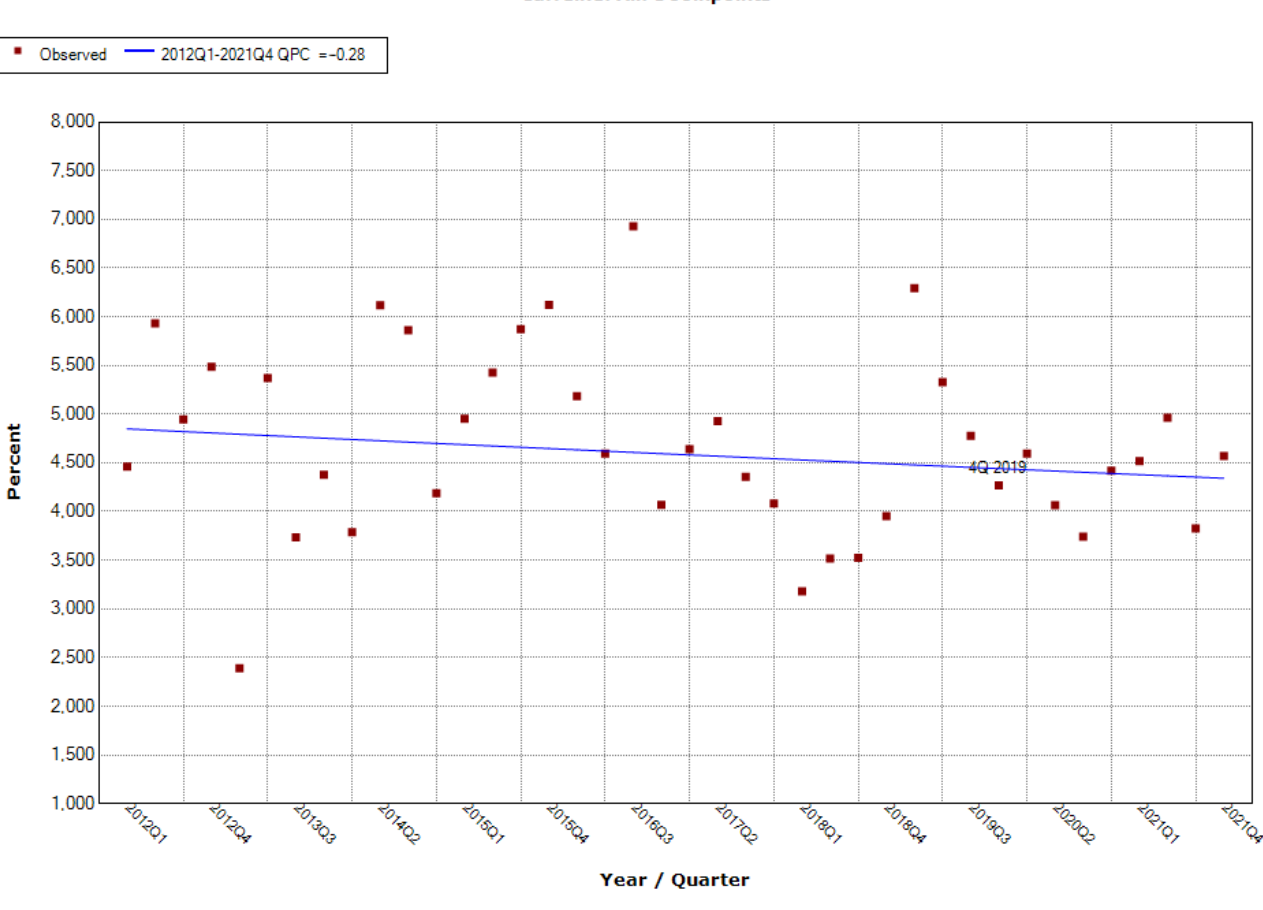
Figure A8. Percentage of products containing caffeine in individual quarters in the period from 2012 to 28 November 2021. Joinpoints mark trend turning points. The date above the observation indicates the moment of publication of the scientific opinion/resolution.